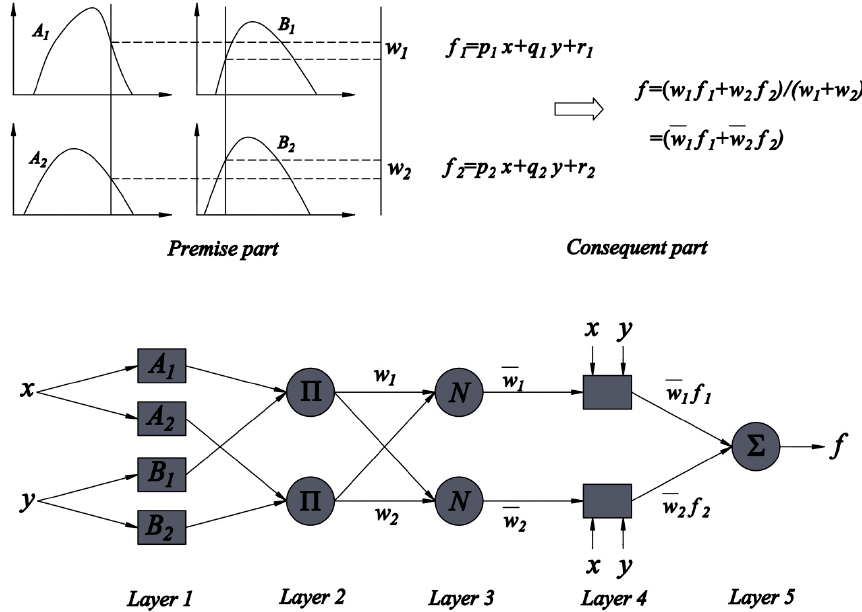
Figure 4. A typical adaptive neuro-fuzzy inference system (ANFIS) model with two inputs and one output.